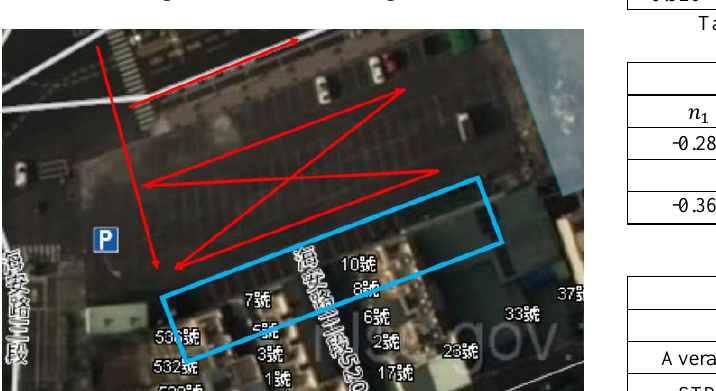
Figure 5. Calibration testing field